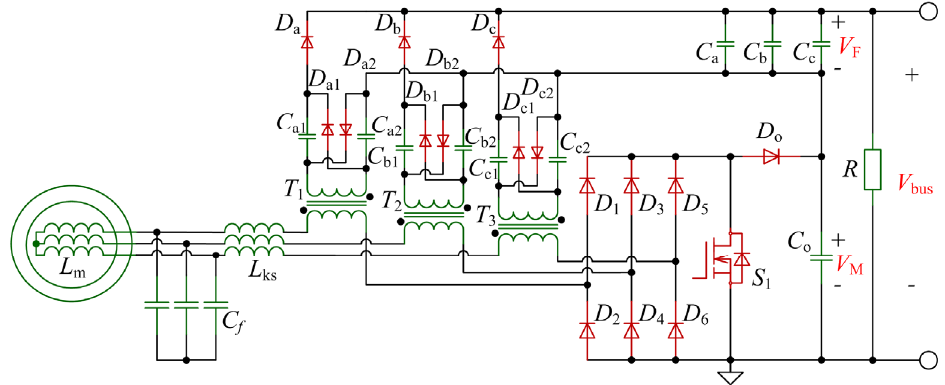
Figure 9. The circuit topology of the proposed